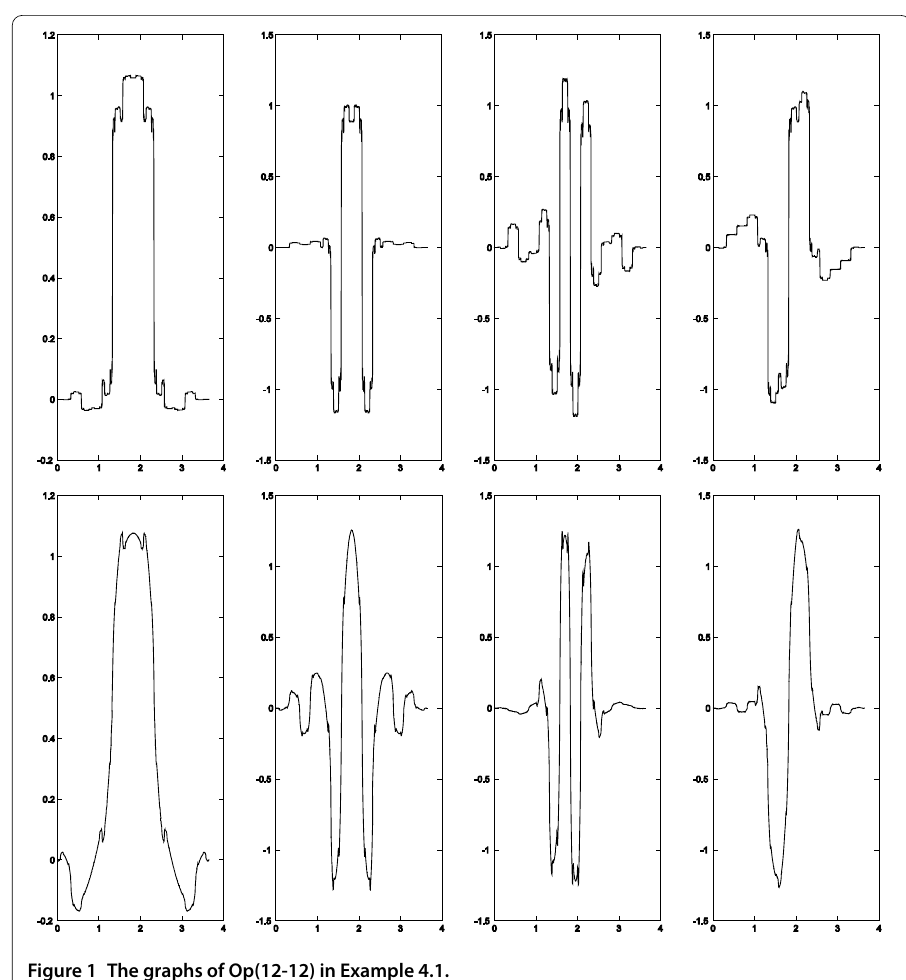
Figure 1 The graphs of Op(12-12) in Example